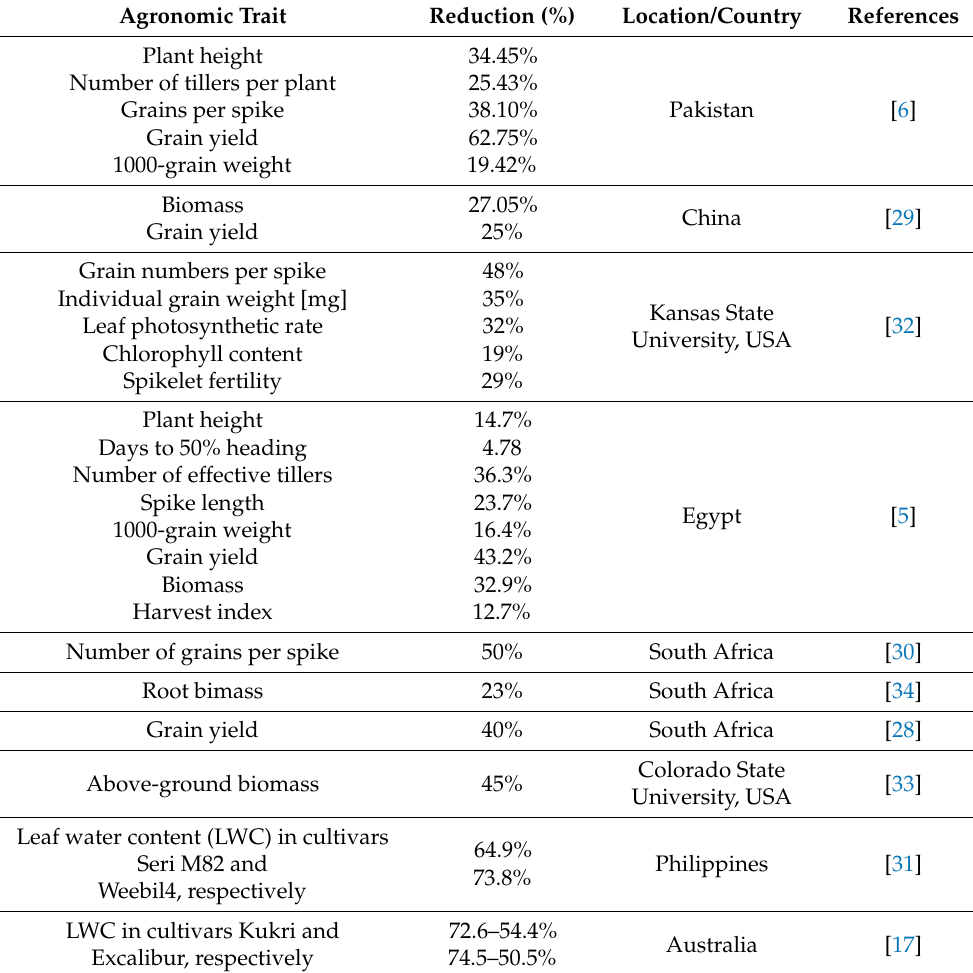
Table 1. Impact of drought stress on agro-physiological traits in